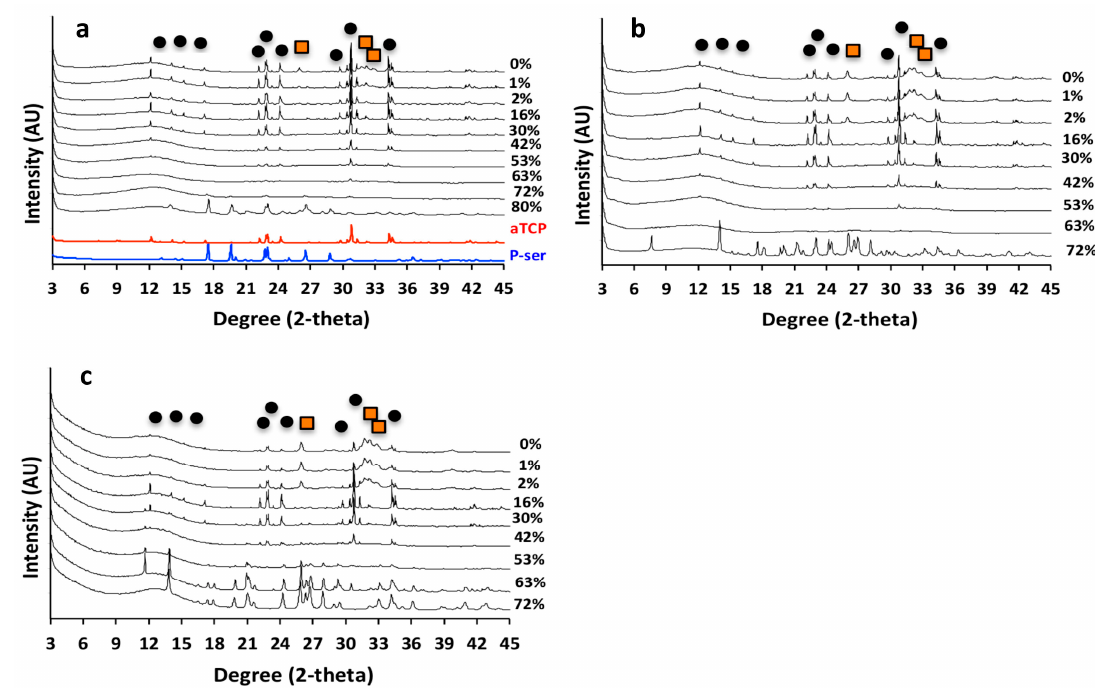
Figure 5. ( a , b , c ) X-ray diffractograms of PM-CPC after curing for 1 (a) or 14 (b) days in 100% humidity, or 14 days in water (c). Crystalline hydroxyapatite peaks (orange squares, a) appeared within 24 h in α TCP CPCs (0% PM-CPC), while as little as 2–16% phosphoserine inhibited hydroxyapatite formation and inhibited the dissolution and transformation of α TCP (black circles, a), even after curing for 14 days in liquid ( c ). Crystalline hydroxyapatite peaks are indicated by orange squares (PDF# 01-074-0565), while crystalline α TCP peaks are indicated by black circles (PDF# 04-010-4348).